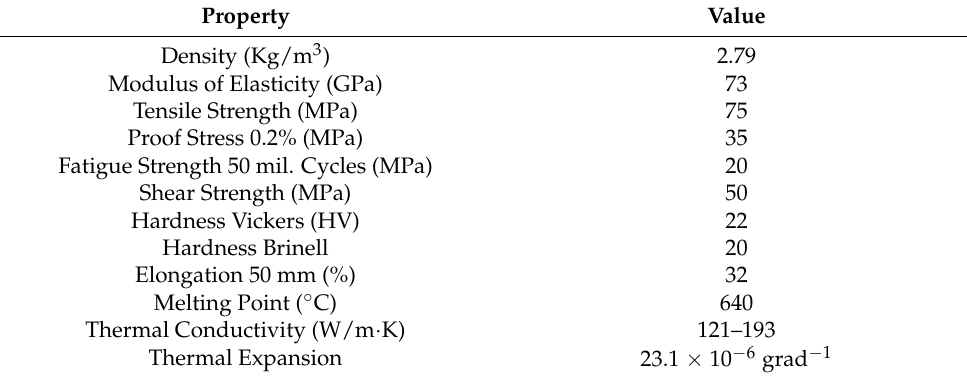
Table 1. Aluminum A1050 properties [38].